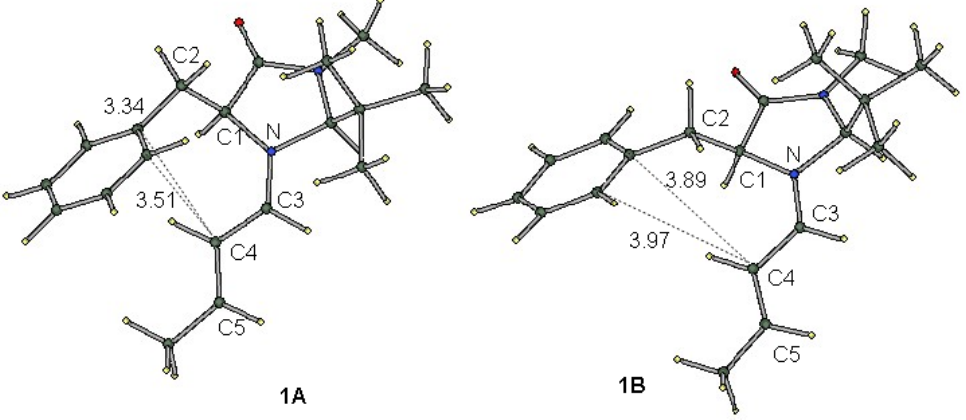
Figure 2. Optimized structures of conformers 1A (Left) and 1B (Right) with atom numbering. The figures indicate the interatomic distances in